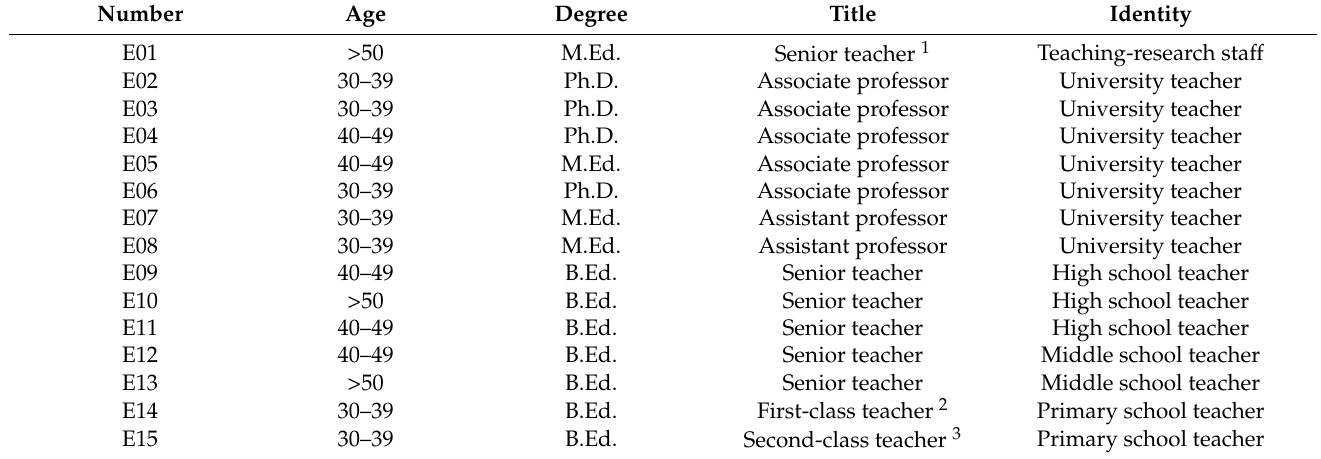
Table 1. Basic Information of Experts.